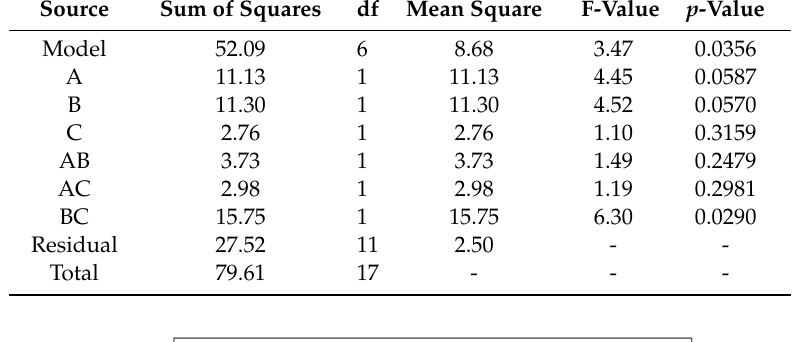
Table 7. Analysis of variance for the statistical significance of the investigated factors (A: drug— stabilizer ratio, B: drug—mannitol ratio, C: inlet temperature) on the ζ -potential after redispersion of the suspensions.